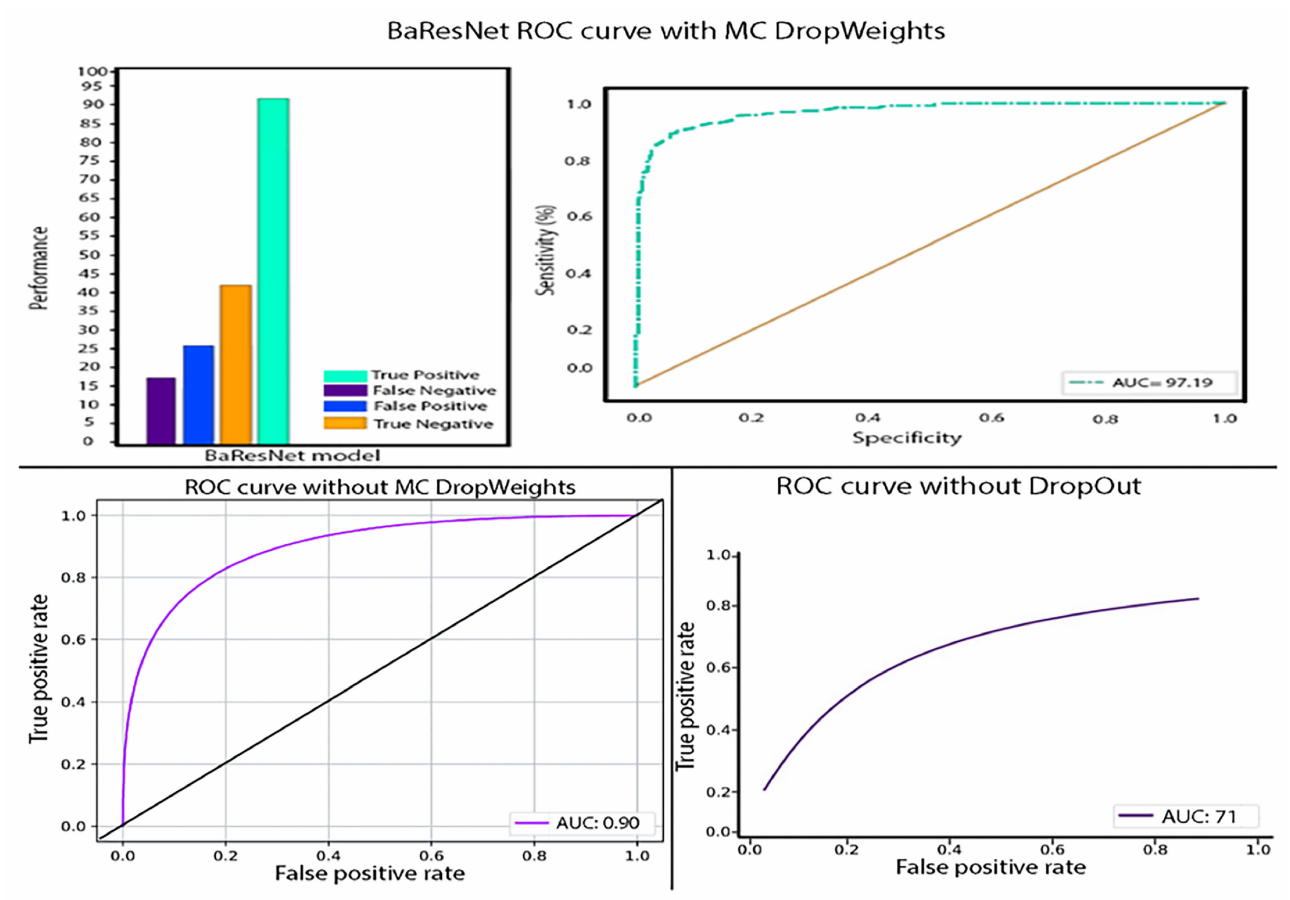
Figure 7. Baresnet model ROC curve and accuracy rates. Moreover, Figure 7 also visualizes the level of uncertainty in the model’s predictions using a heat map. The darker colors on the map correspond to higher uncertainty levels, indicating that the model faced difficulty arriving at a consensus on the predicted label for samples located in regions of high color intensity. This indicates that the model experienced high predictive uncertainty in such